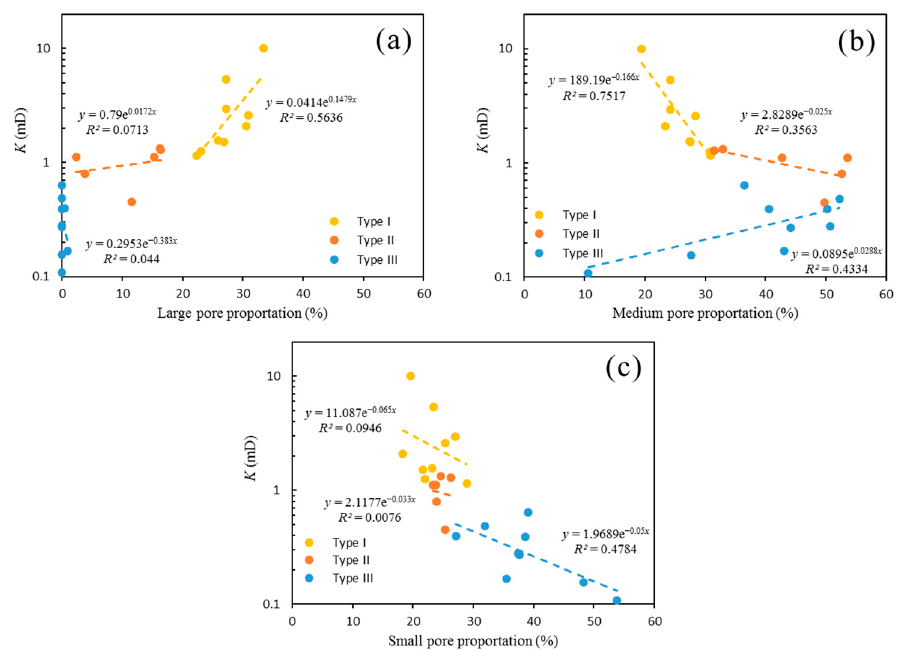
Figure 6. Relationships of the different pore proportion of different pore structure types: ( a )